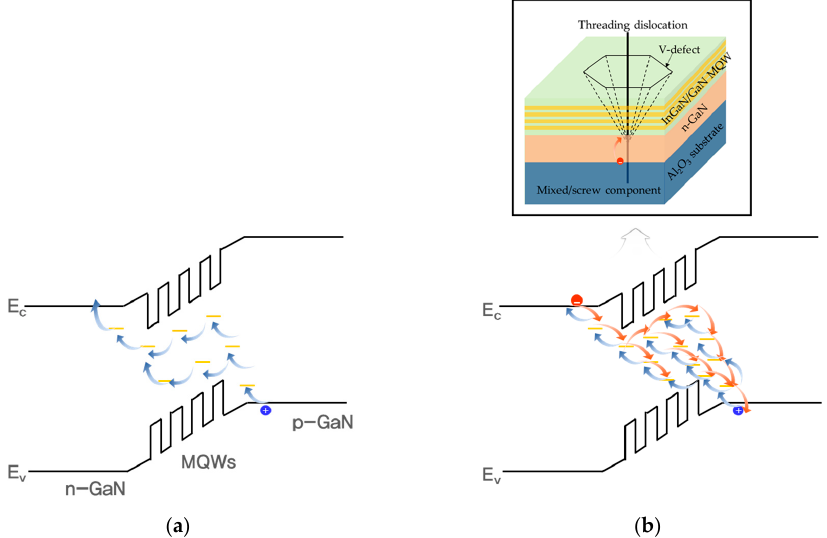
Figure 3. Energy band diagram with different V-shaped defect densities for ( a ) LED I, and ( b ) LED II. The inset depicts the carrier conduction along V-shaped defects with a component of mixed and screw dislocations. The red and blue solid dots represent the electrons and heavy holes, respectively.